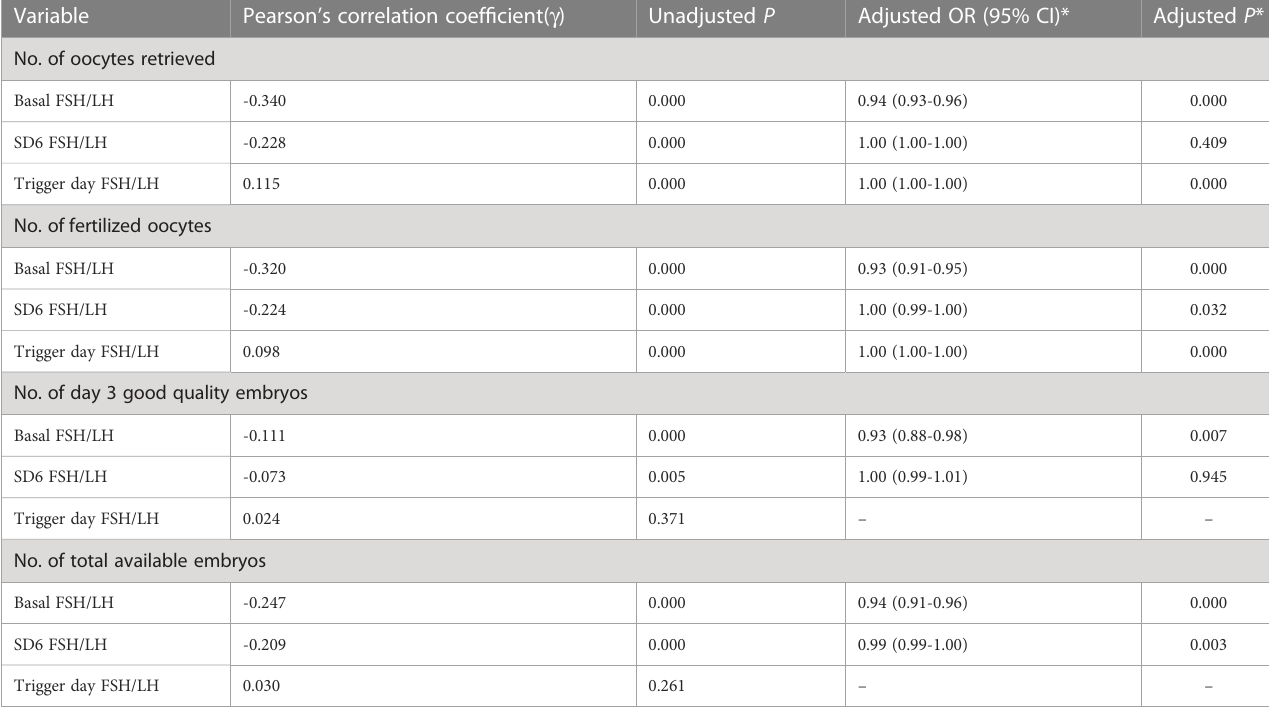
TABLE 1 Correlation analysis and Poisson regression analysis of factors associated with embryological outcomes.